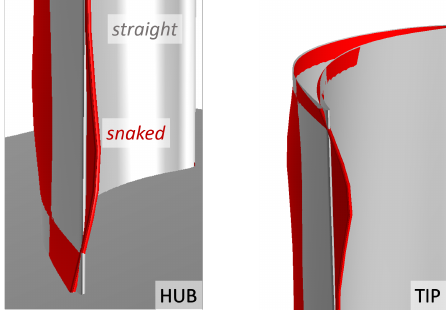
Figure 6. Comparison between straight and “snaked”